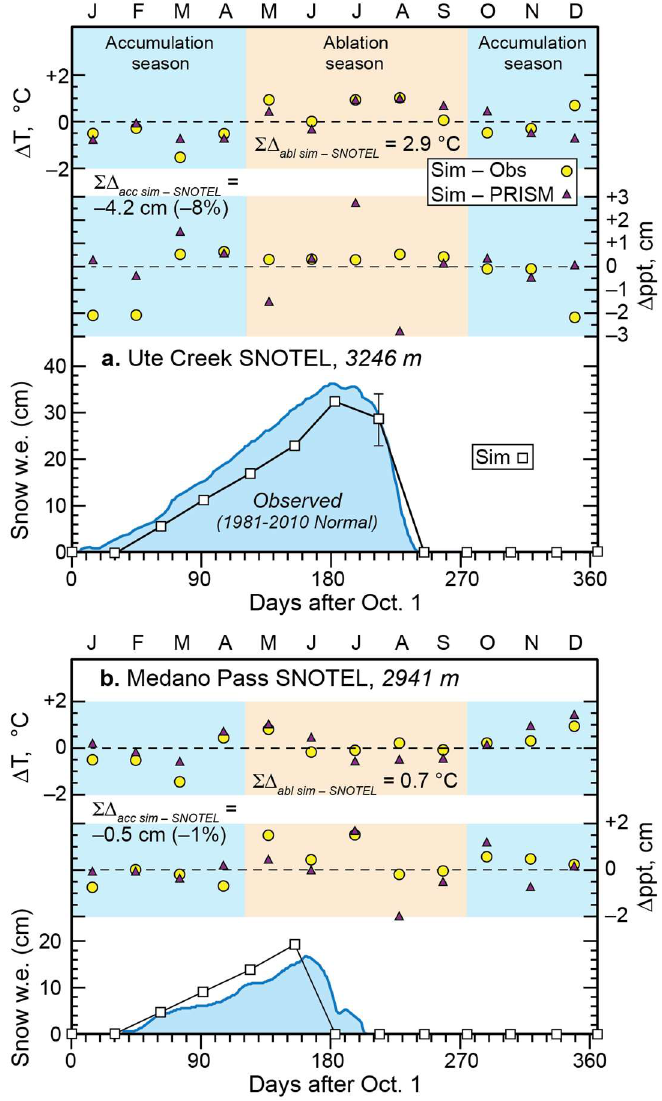
Figure 8. Differences between simulated and observed mean monthly temperature (∆T), precipitation (∆ppt), and snowpack evolution at SNOTEL stations in ( a ) Ute Creek SNOTEL and ( b ) Medano Pass. Positive differences indicate simulation values are warmer/wetter, negative values cooler/drier. The cumulative differences Σ∆ from SNOTEL values for the ablation and accumulation seasons are also given. PRISM values are shown for completeness. Error bars associated with simulated snowpack, where shown, reflect variation in melt factors.